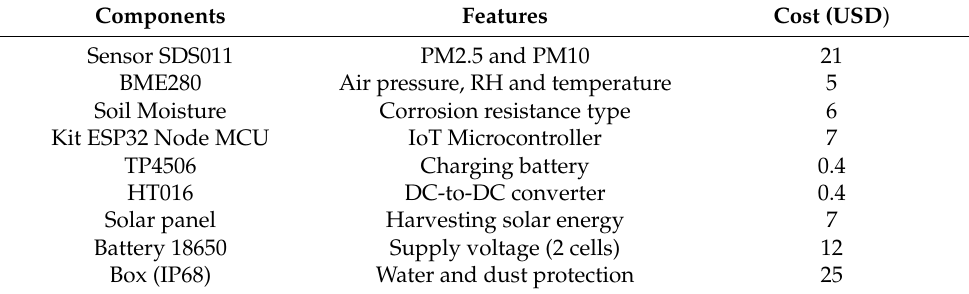
Table 1. Main components of each sensor module.